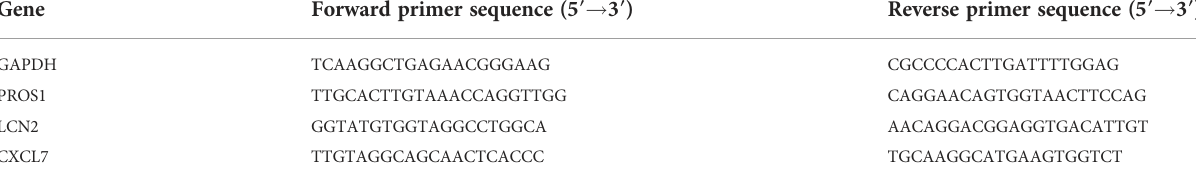
TABLE 2 The primer sequences used for Q-PCR.